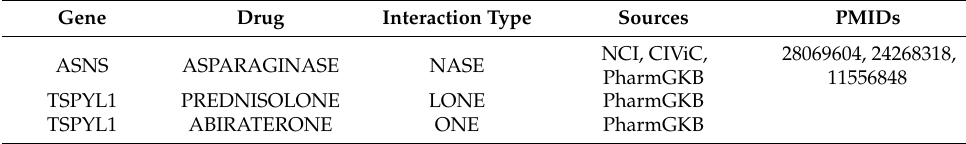
Table 1. The potential compounds of two genes were identified using